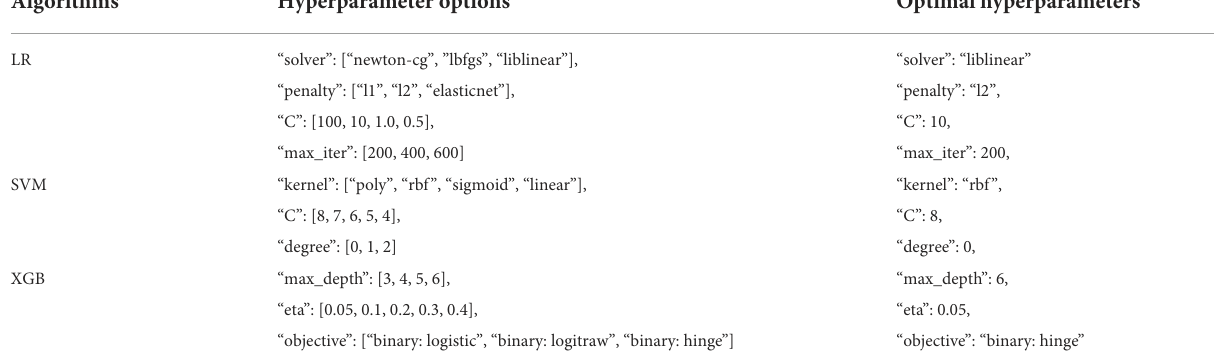
TABLE 2 Hyperparameter options for each